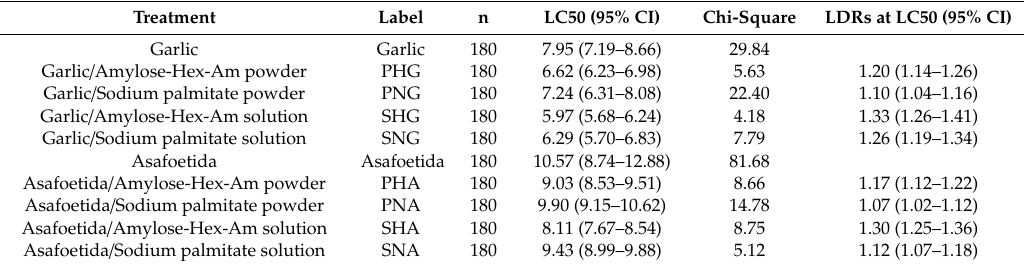
Table 1. LC 50 values for garlic and asafoetida essential oil emulsions relative to bulk essential dose